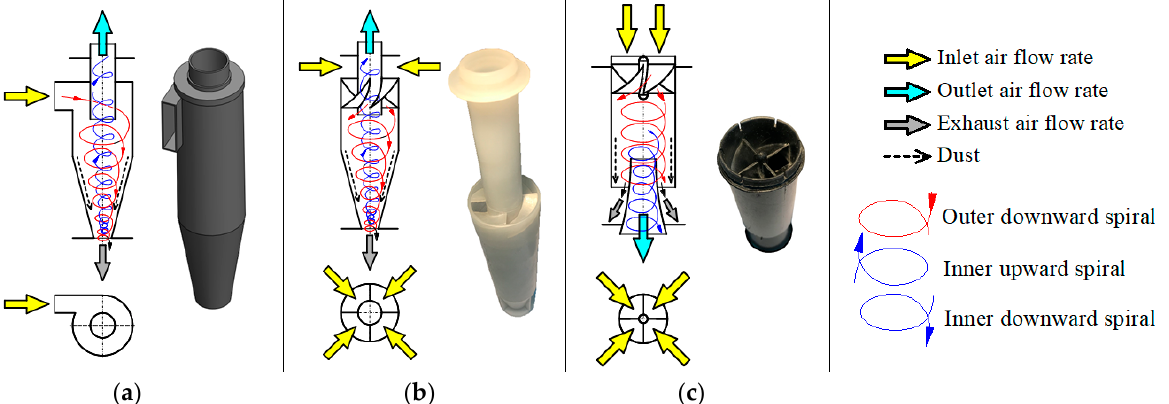
Figure 2. Cyclone types used for filtering the intake air in the motor vehicles: ( a ) reverse-flow cyclone, ( b ) reverse-flow with axial inlet, and ( c ) axial flow cyclone (vortex tube separators).